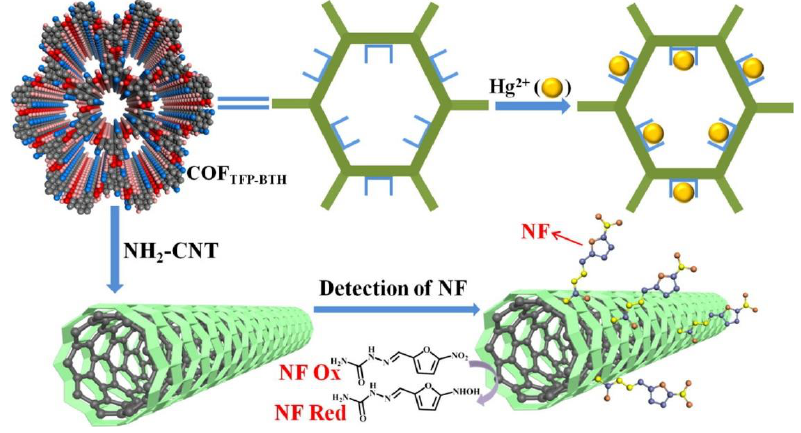
Figure 4. Schematic illustration of MWCNTs@COF-TFP-BTH showing possible adsorption sites for Hg 2+ and nitrofural. Reprinted with permission from Ref. [109]. Copyright 2022